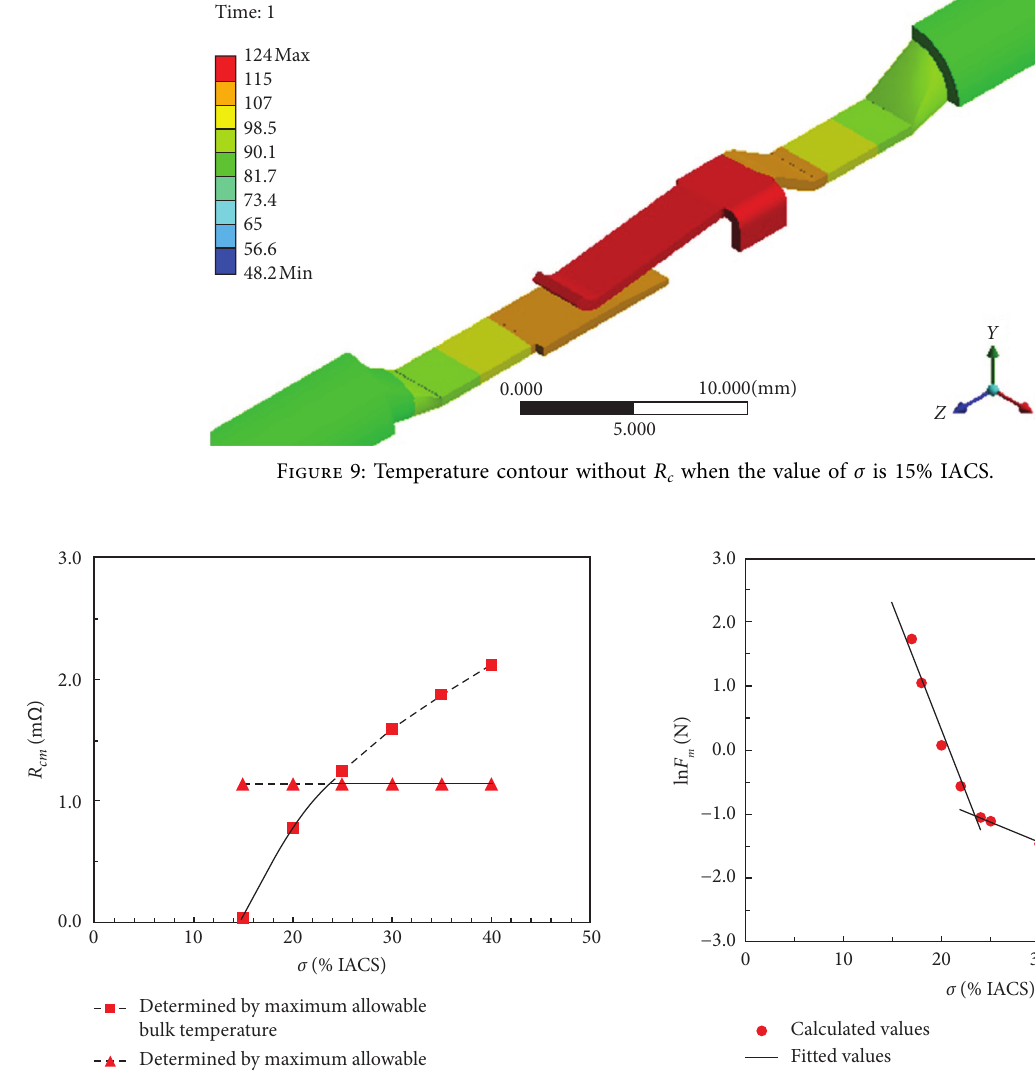
Figure 11: The relationship between ln F